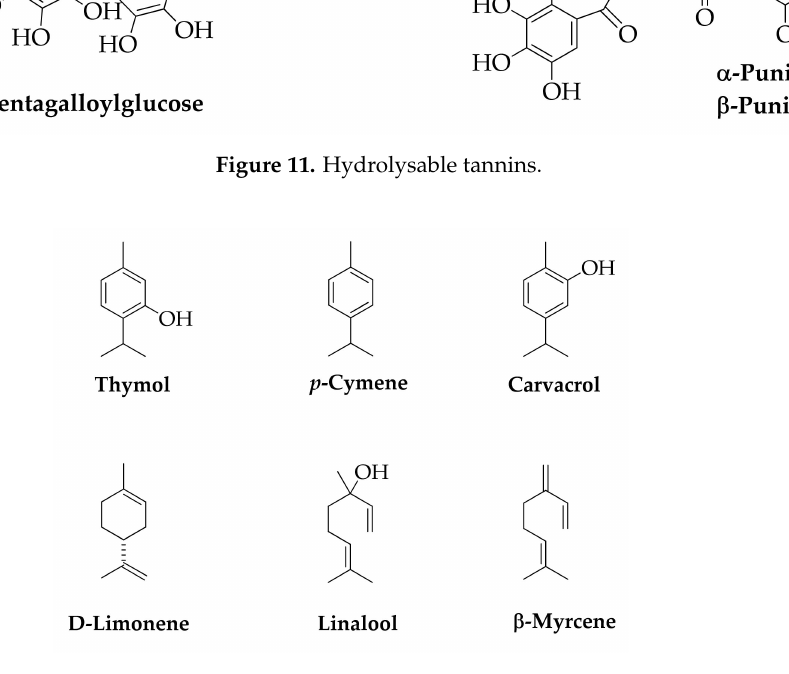
Figure 12. Terpenes. Fruit peel generated from industrial processes are sources of terpenes; in particular, orange peel waste is rich of D-limonene, linalool, and myrcene (Figure 12) [158]; tomato peel of lycopene [159] and melon peel of carotenoids as β -carotene, zeaxanthin, violaxanthin, and lutein (Figure 13) [160]. In industrial sectors, terpenes find several applications as biopesticides, fragrances, flavors, and food supplements